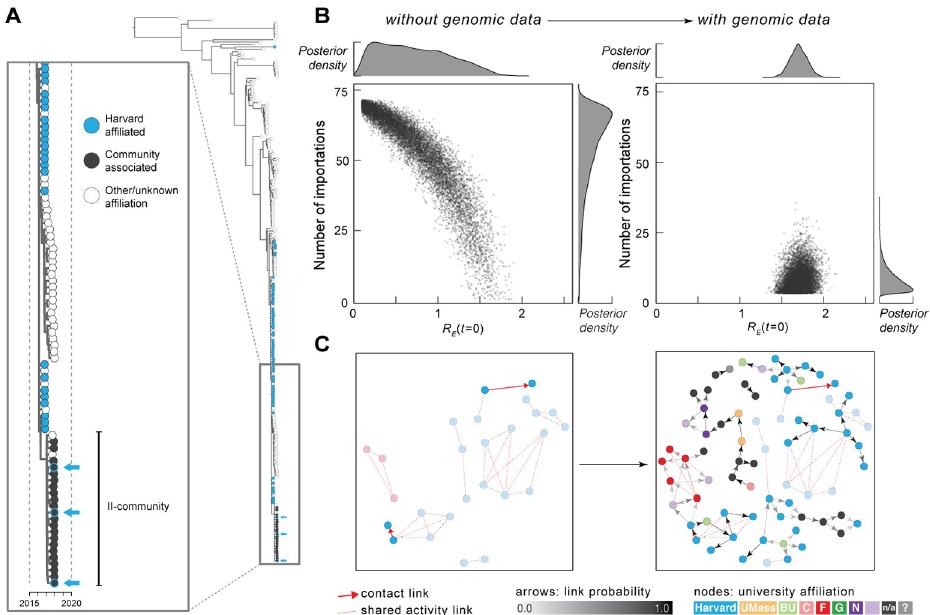
Fig 2. Epidemiological modeling and transmission reconstruction. (A) Zoom view of Clade II-community and its ancestors (see Fig 1A). Arrows: individuals affiliated with both II-community and Harvard. (B) Number of importations into Harvard calculated without (left) and with (right) viral genetic information as input. Each point represents a sample from the posterior distribution of R E ( t = 0) and the number of introductions, based on simulated transmission dynamics. (C) Transmission reconstruction of individuals within Clade II-outbreak; samples are colored by institution affiliation (light purple: other institution; n/a: no affiliation; question mark: unknown affiliation). Left: reconstruction using epidemiological data only; all individuals in Clade II-outbreak with known epidemiological links (red arrows) are shown. Right: reconstruction using mumps genomes and collection dates. Arrow shading indicates probability of direct transmission between individuals (minimum probability shown: 0.3); cases with 1 or more inferred links are shown and are colored by institution. Arrows outlined in red represent transmission events identified by both genomic and epidemiological data. Faded nodes are those only connected by shared activity links (i.e., no inferred or known direct transmission). BU, Boston University; Harvard, Harvard University; R E , effective reproduction number; UMass, University of Massachusetts